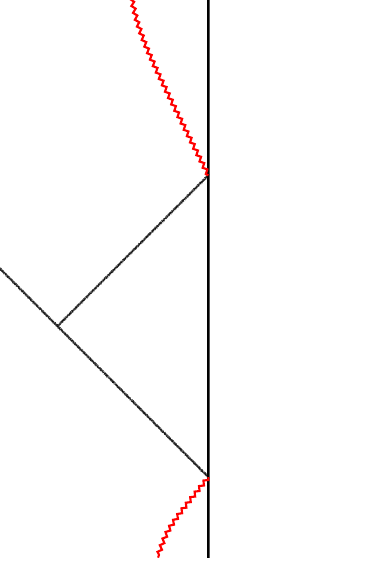
Figure 3 . Penrose diagram of the two-sided black hole spacetime deformed by the antichiral matter χ = χ ( x + )